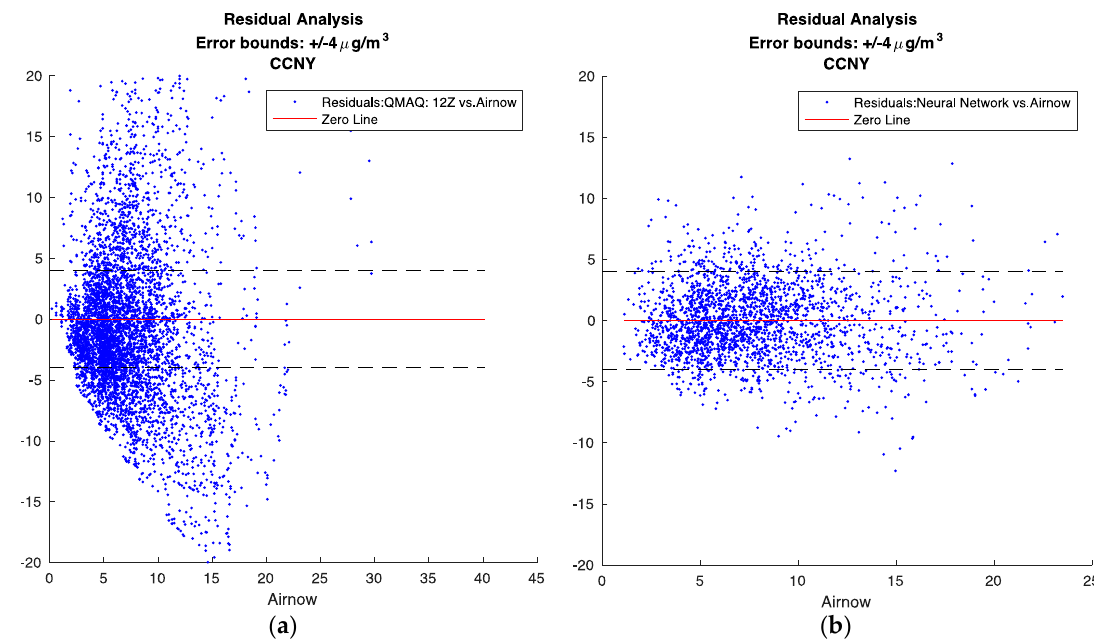
Figure 7. Residual analysis. The standard deviation of PM 2.5 from the AirNow ground monitoring sites was calculated to be 4 μ g/m 3 , therefore, +/ − 4 μ g/m 3 was used for the error bounds ( a ) CMAQ; ( b ) Neural Network